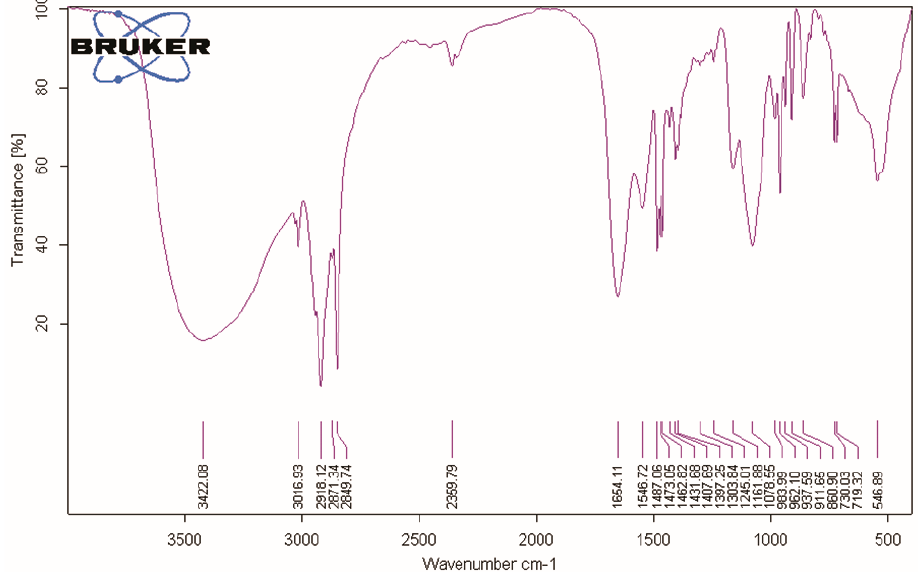
Figure 8. Fourier transform infrared spectroscopy (FTIR) spectrum of SPION2.